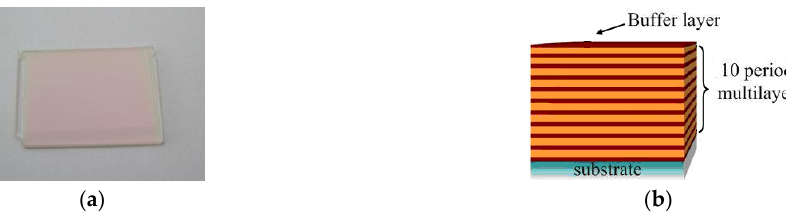
Figure 2. ( a ) photograph of the fabricated 1D PBG structure on a ZF 10 glass substrate ( b ) structure of 1D PBG.